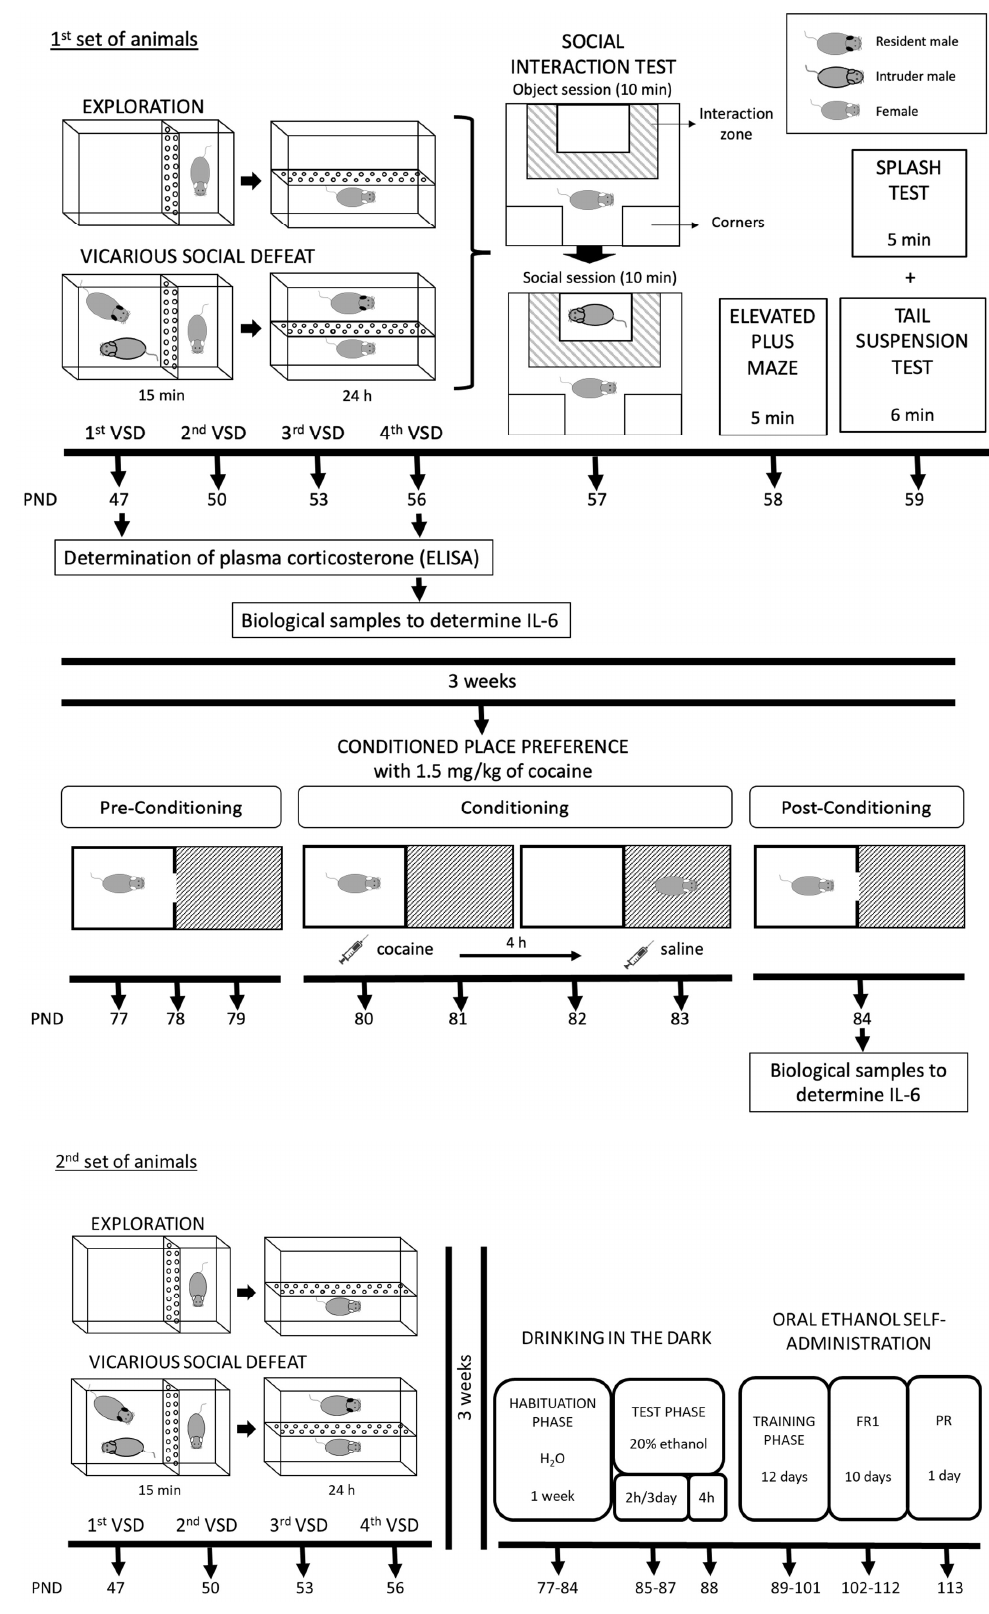
Figure 1. Experimental design and experimental groups of two mice sets.